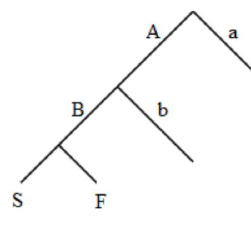
Figure 1. An example of the event tree: setting up a main route. Setting up a main route, the operator must select and push the appropriate start and end buttons on the control panel. The meaning of branch A-a is as follows: (A)—the right choice and service of the start button, (a)—incorrect operation of the start button. The meaning of branch B-b is analogical for the end button. The symbol S represents the successful issuing of the order for setting up the main route, and the symbol F represents its